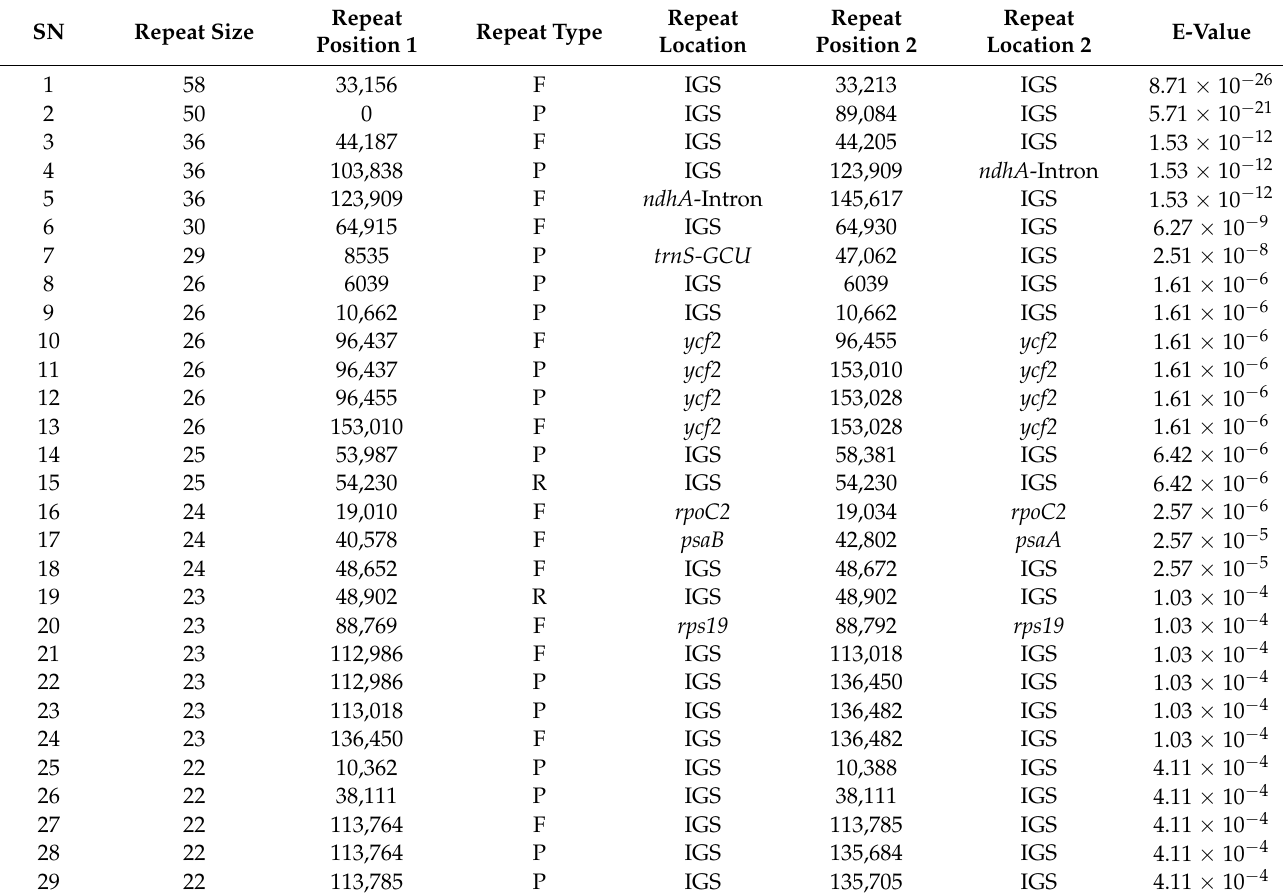
Table 6. Repeat sequences present in the A. fruticosum chloroplast